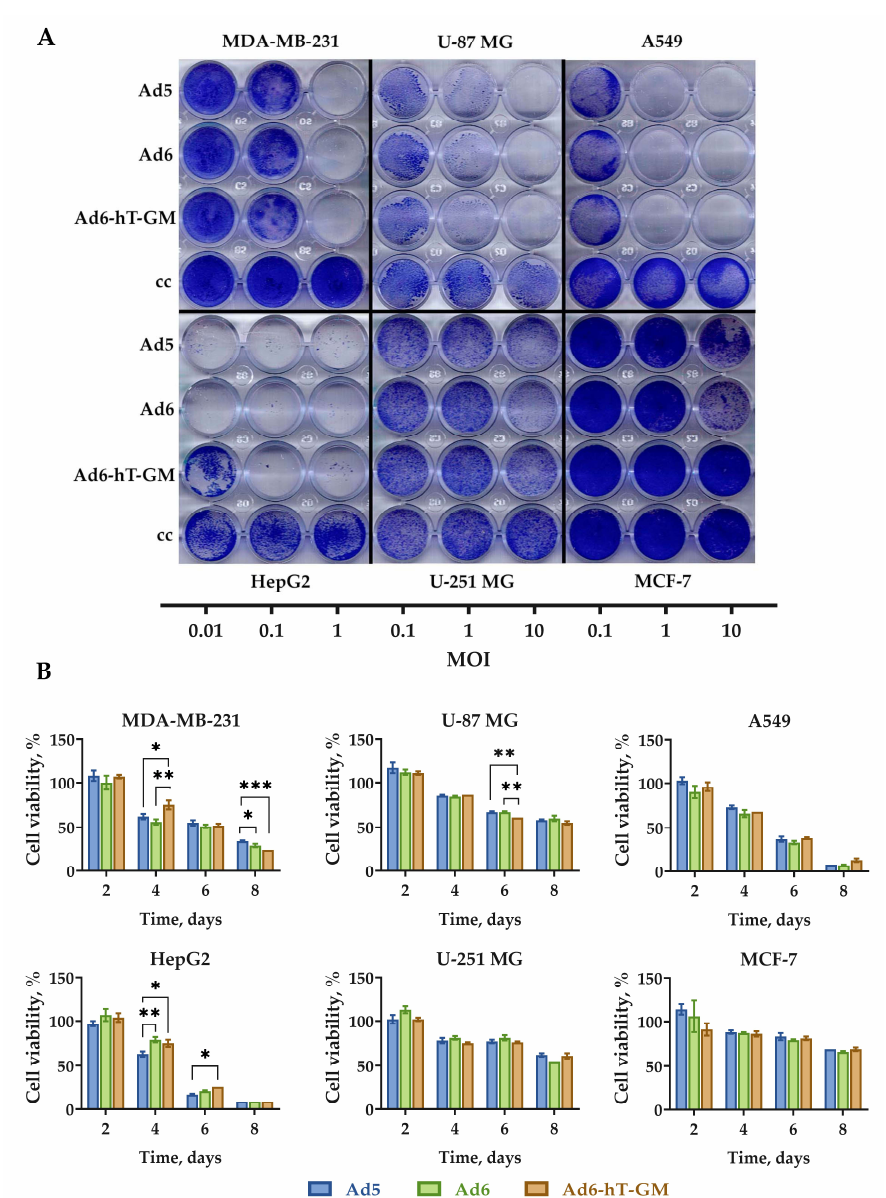
Figure 5. Comparison of the in vitro oncolytic effect of Ad5, Ad6 and Ad6-hT-GM in various cell lines. ( A ) Cells were infected at 0.1–10 vp/cell with the indicated viruses, 8 days post-infection (dpi) cell viability was assessed by crystal violet assay. ( B ) Cells were infected at 100 vp/cell with the indicated viruses, and cell viability was measured 2, 4, 6, and 8 dpi by XTT assay. Data are presented as mean ± SD ( n = 3). The differences between cell viability levels were analyzed by ANOVA followed by Tukey’s HSD post-hoc test for pairwise comparisons. * p < 0.05, ** p < 0.01, *** p < 0.001.